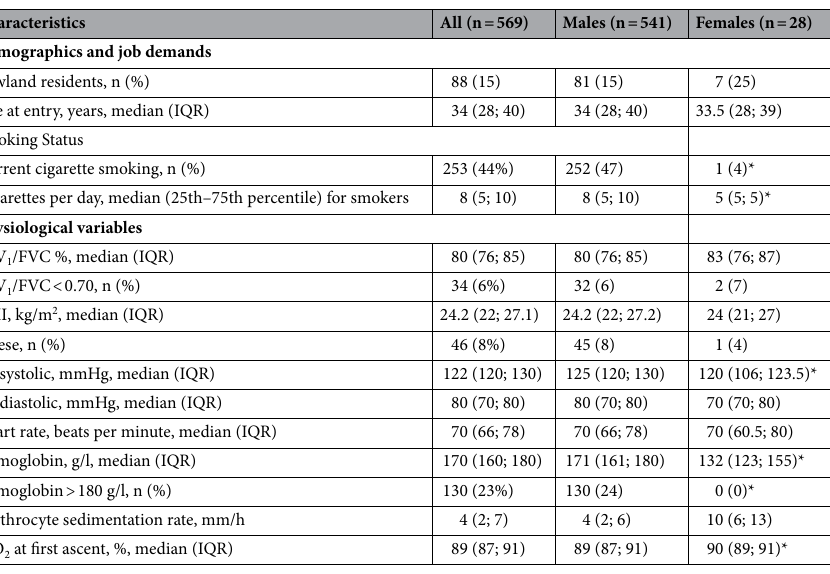
Table 1. The overall and sex-specific demographic and physiological characteristics of the cohort at entry. IQR interquartile range,